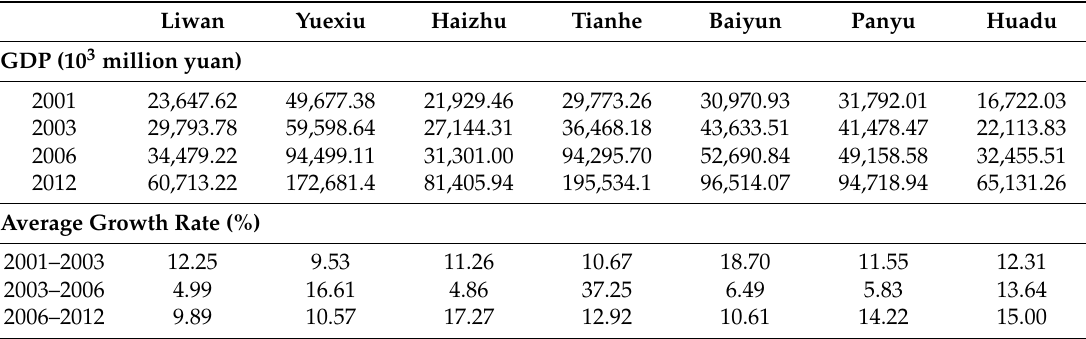
Table 5. District-level gross domestic products (GDP) and average growth rates from 2001 to 2012. Liwan Yuexiu Haizhu Tianhe Baiyun Panyu Huadu GDP (10 3 million yuan)